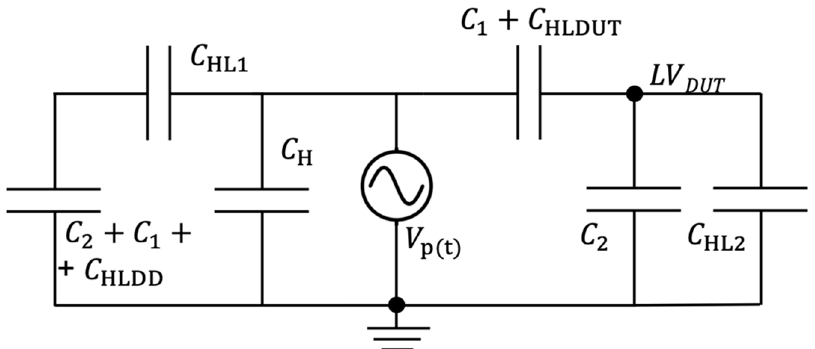
Figure 6. Equivalent circuit of the test condition T3.